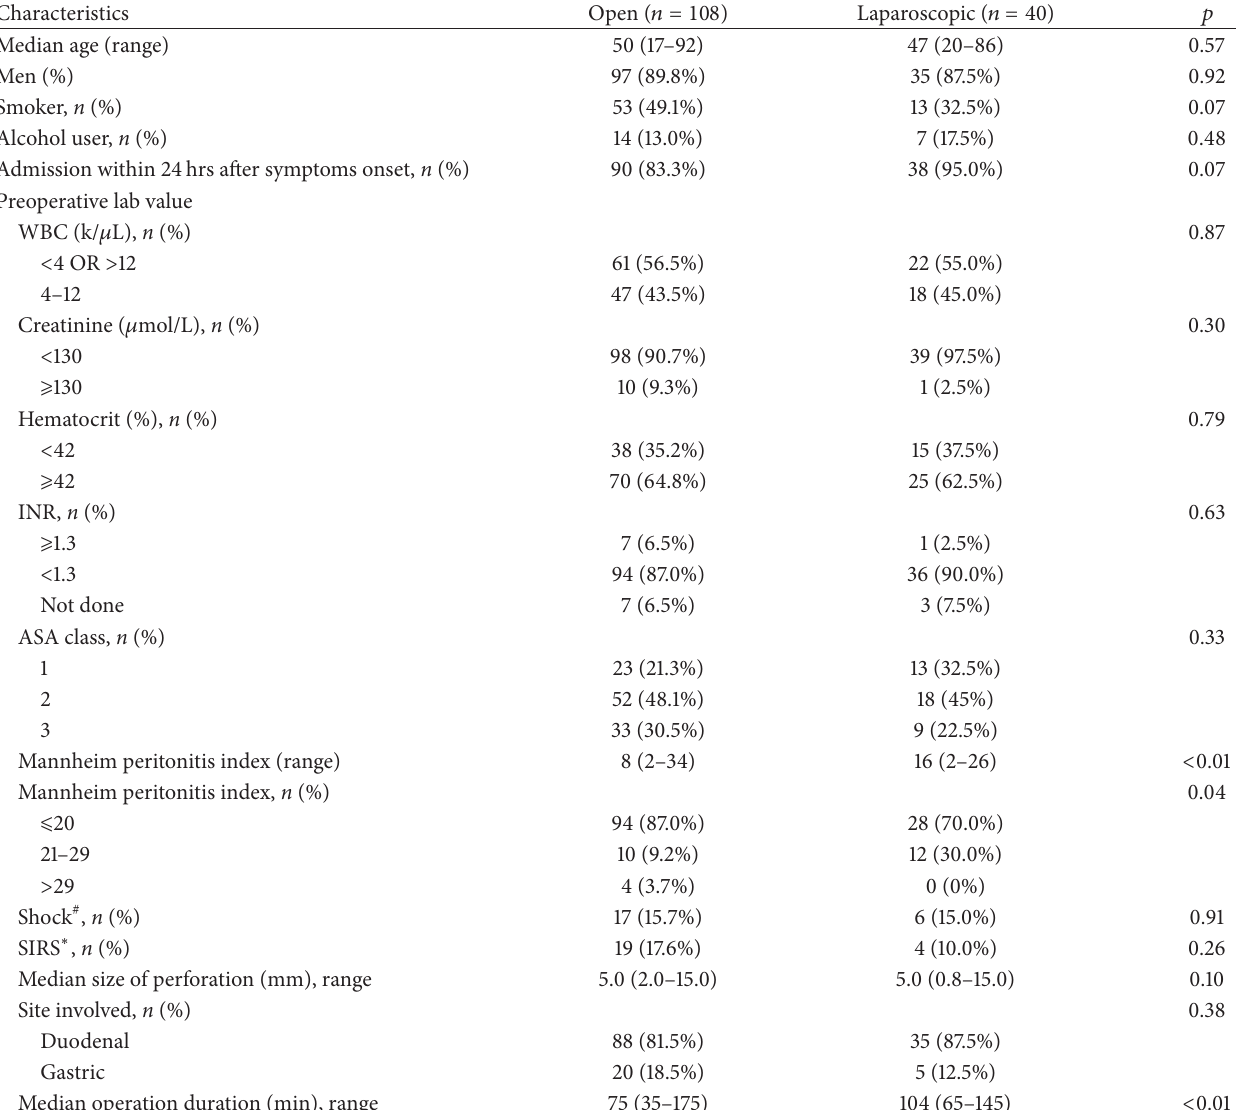
Table 1: Patient